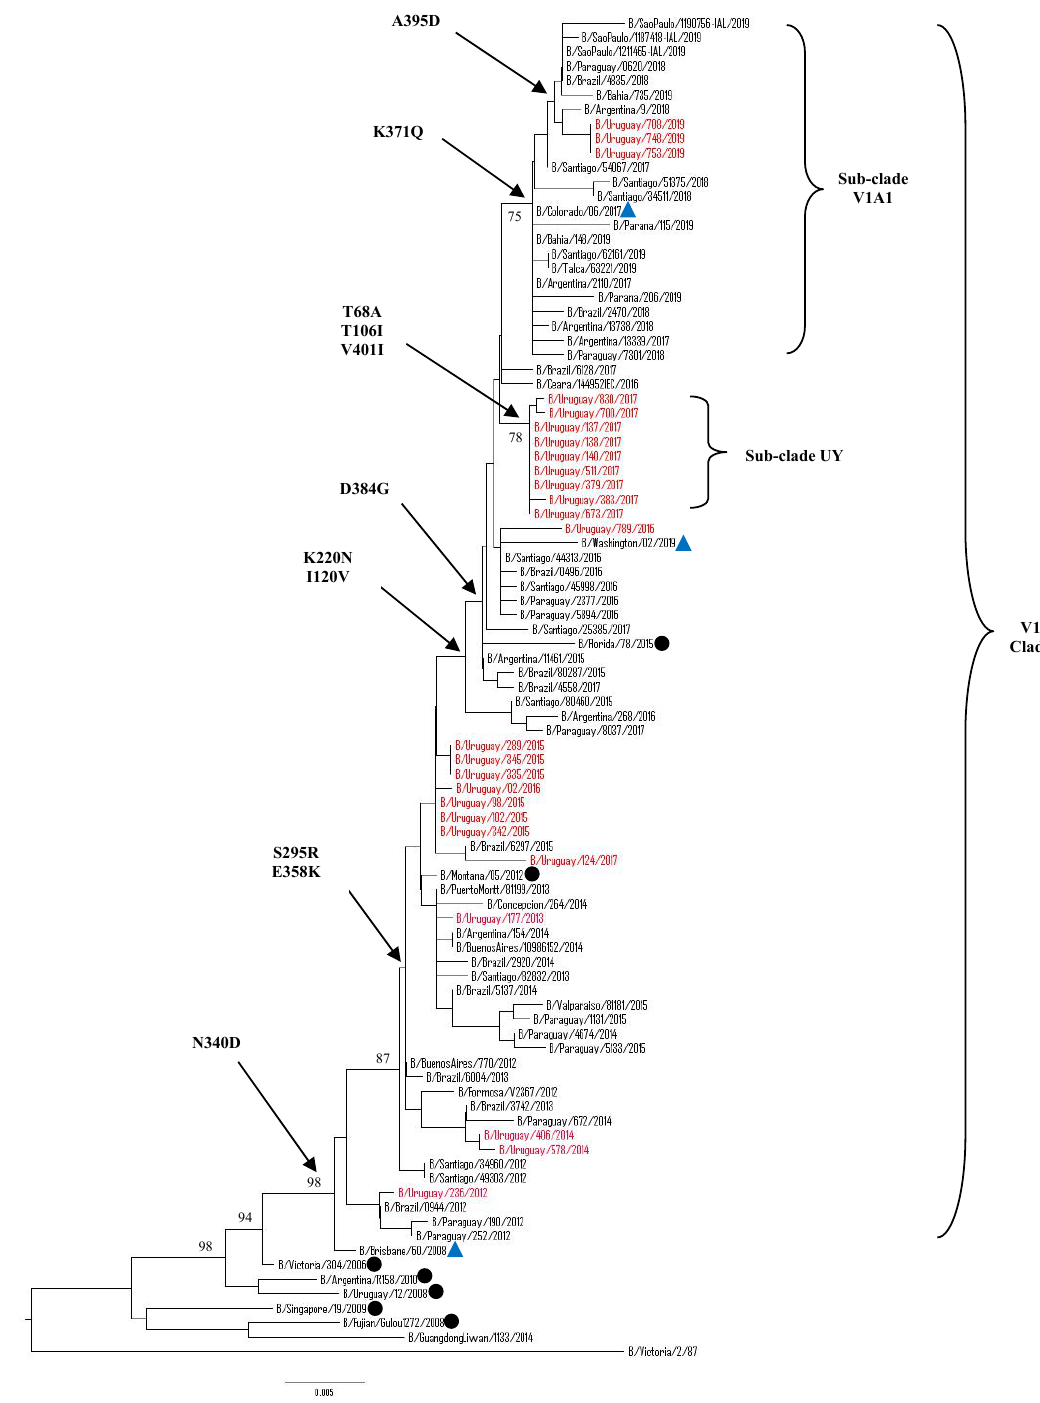
Figure 6. Phylogenetic analysis of the partial neuraminidase nucleotide sequences from influenza B Victoria-lineage viruses circulating in Uruguay from 2012 to 2019.The phylogeny tree was generated by the neighbour-joining method with 1000 bootstrap replicates. Bootstrap values > 70 are shown in the nodes. Vaccine strains are shown with a blue triangle. Uruguayan strains are shown in red while representative clade strains are indicated with a black circle as a symbol. The scale bar indicates substitutions per site. The most relevant amino acid substitutions found are indicated with arrows.